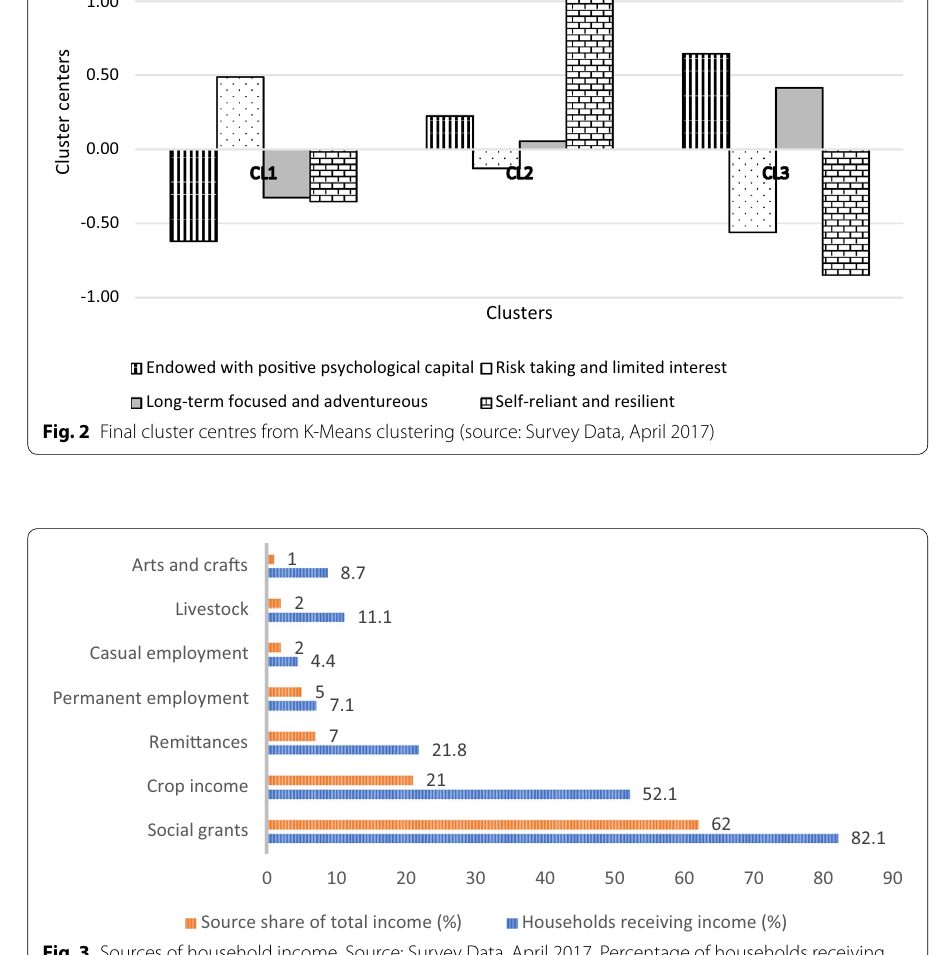
Fig. 3 Sources of household income. Source: Survey Data, April 2017. Percentage of households receiving income does not add up to 100% because many households have multiple income